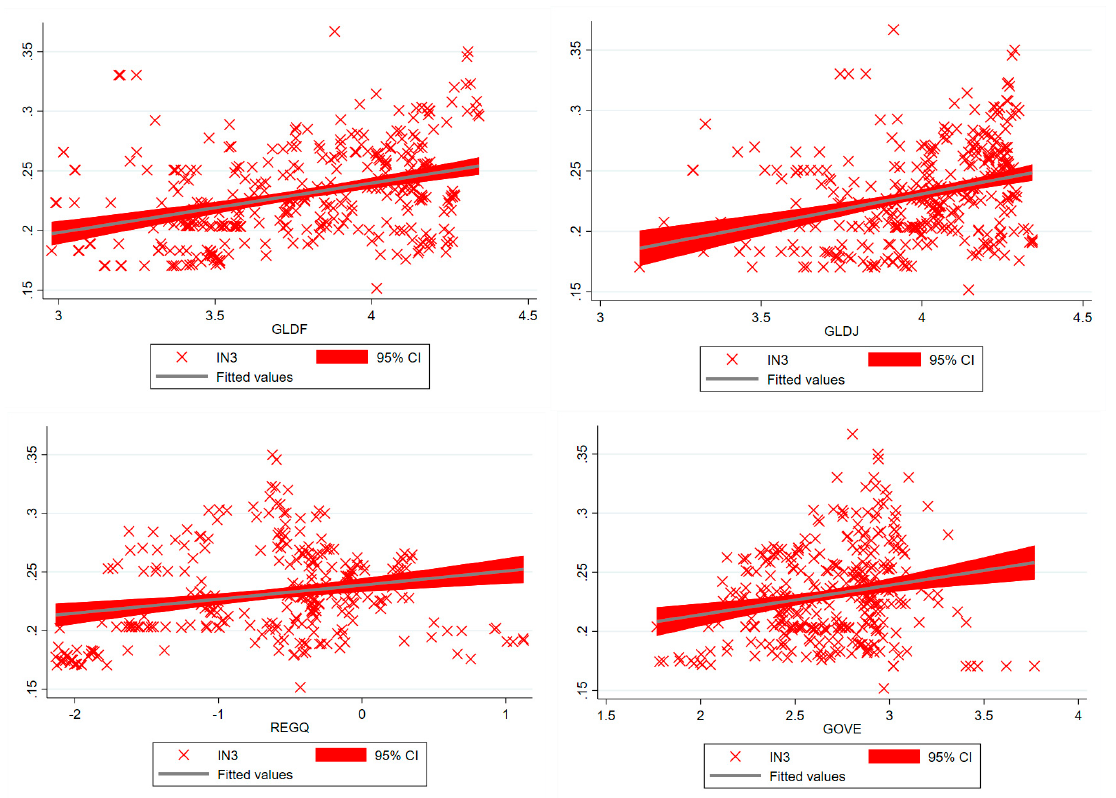
Figure 4. Fi tt ed values for income inequality and globalization dynamics. Note: CI—Con fi dence Figure 4. Fitted values for income inequality and globalization dynamics. Note: CI—Confidence interval. Legend: IN3—The income share of the bo tt om 60%, GLDF—Globalization de facto; GLDJ— interval. Legend: IN3—The income share of the bottom 60%, GLDF—Globalization de facto; GLDJ— Globalization de jure . Globalization de